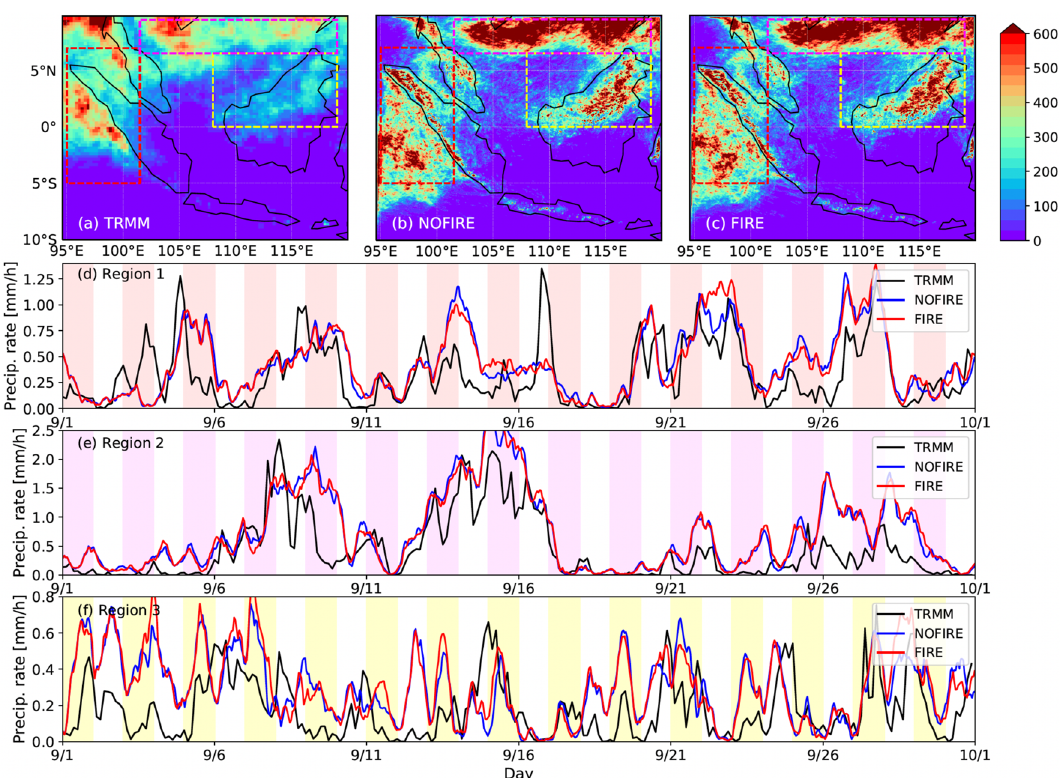
of Region 1 (95 W–101.5 W, 5 S–7 N), Region 2 (101.5 W–119 W, 6.5 N–9.5 N), and Region 3 (108 W–119 W, 0–6.5 N), respectively. Time series of TRMM (black, 3-hourly) and simulated (blue and red, hourly) precipitation rates (mm/h), averaged over each region, are shown for ( d ) Region 1, ( e ) Region 2, and ( f ) Region 3. An equivalent figure for the CHEM runs can be found in